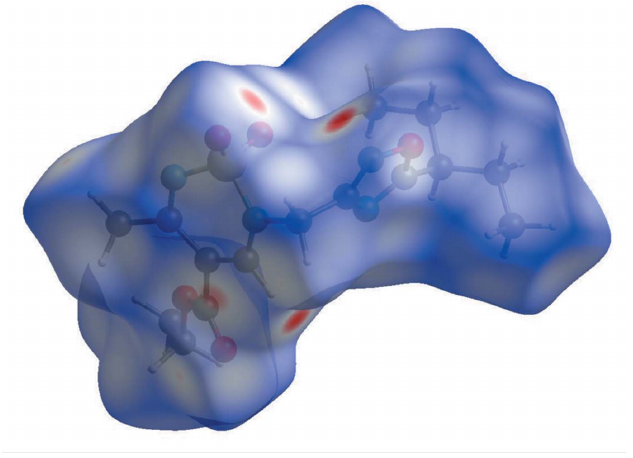
Figure 6 ( a ) The two-dimensional fingerprint plot for compound 3 , and delineated into ( b ) H (cid:3)(cid:3)(cid:3) H (48.7%), ( c ) O (cid:3)(cid:3)(cid:3) H/H (cid:3)(cid:3)(cid:3) O (27.5%), ( d ) N (cid:3)(cid:3)(cid:3) H/H (cid:3)(cid:3)(cid:3) N (14.9%) and ( e ) C (cid:3)(cid:3)(cid:3) H/H (cid:3)(cid:3)(cid:3) C (5.2%)